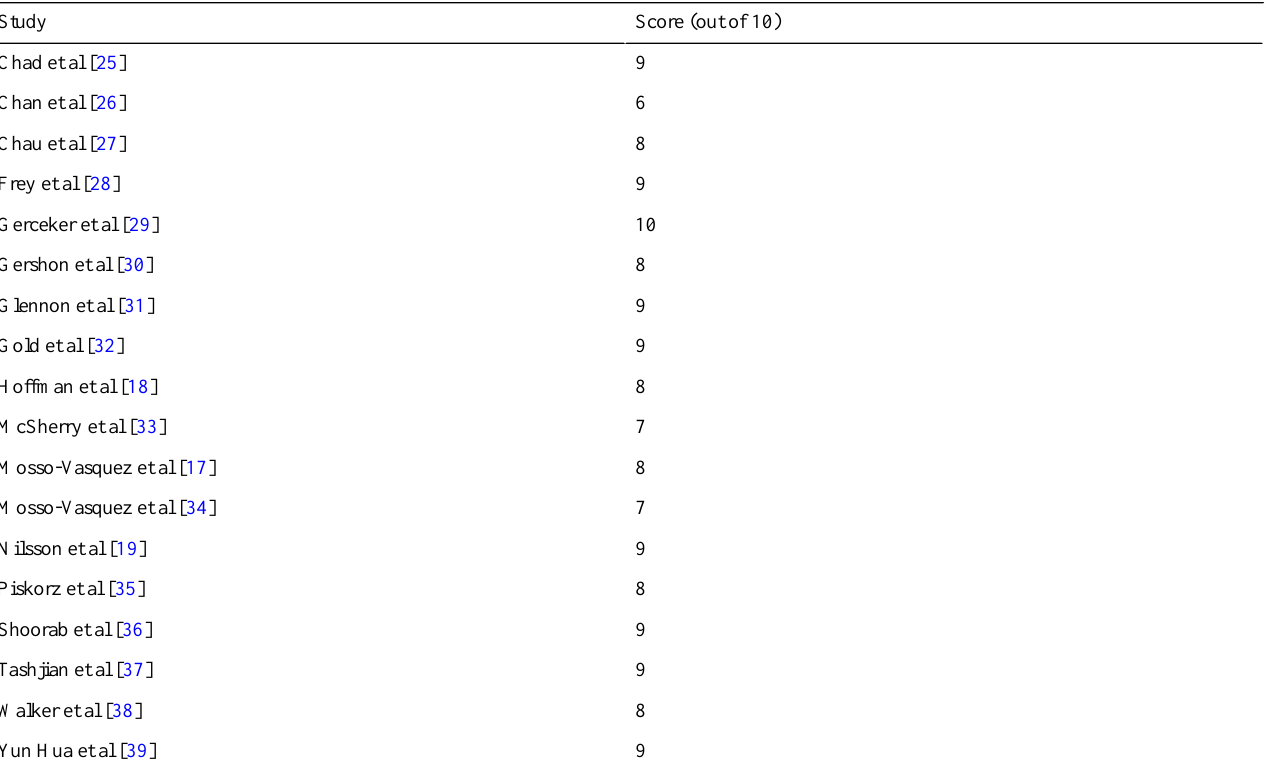
Table 1. Summary of bias assessment results using modified Downs and Black checklist.